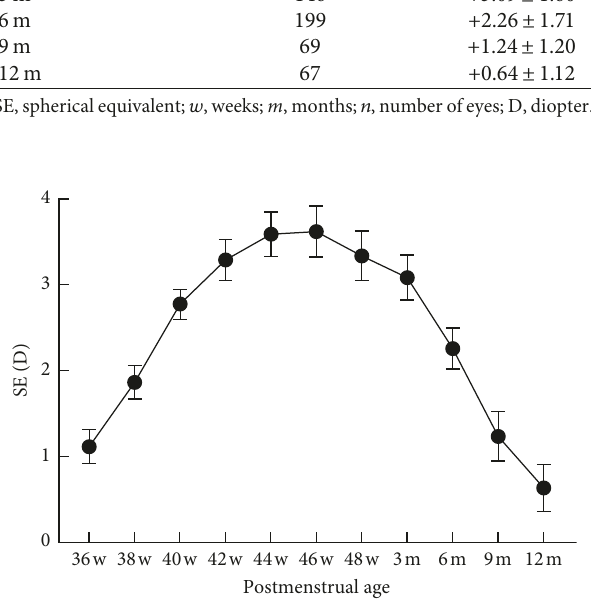
Figure 1: Correlation between SE and postmenstrual age. SE, spherical equivalent; D, diopter. Table 2: SE of different genders.